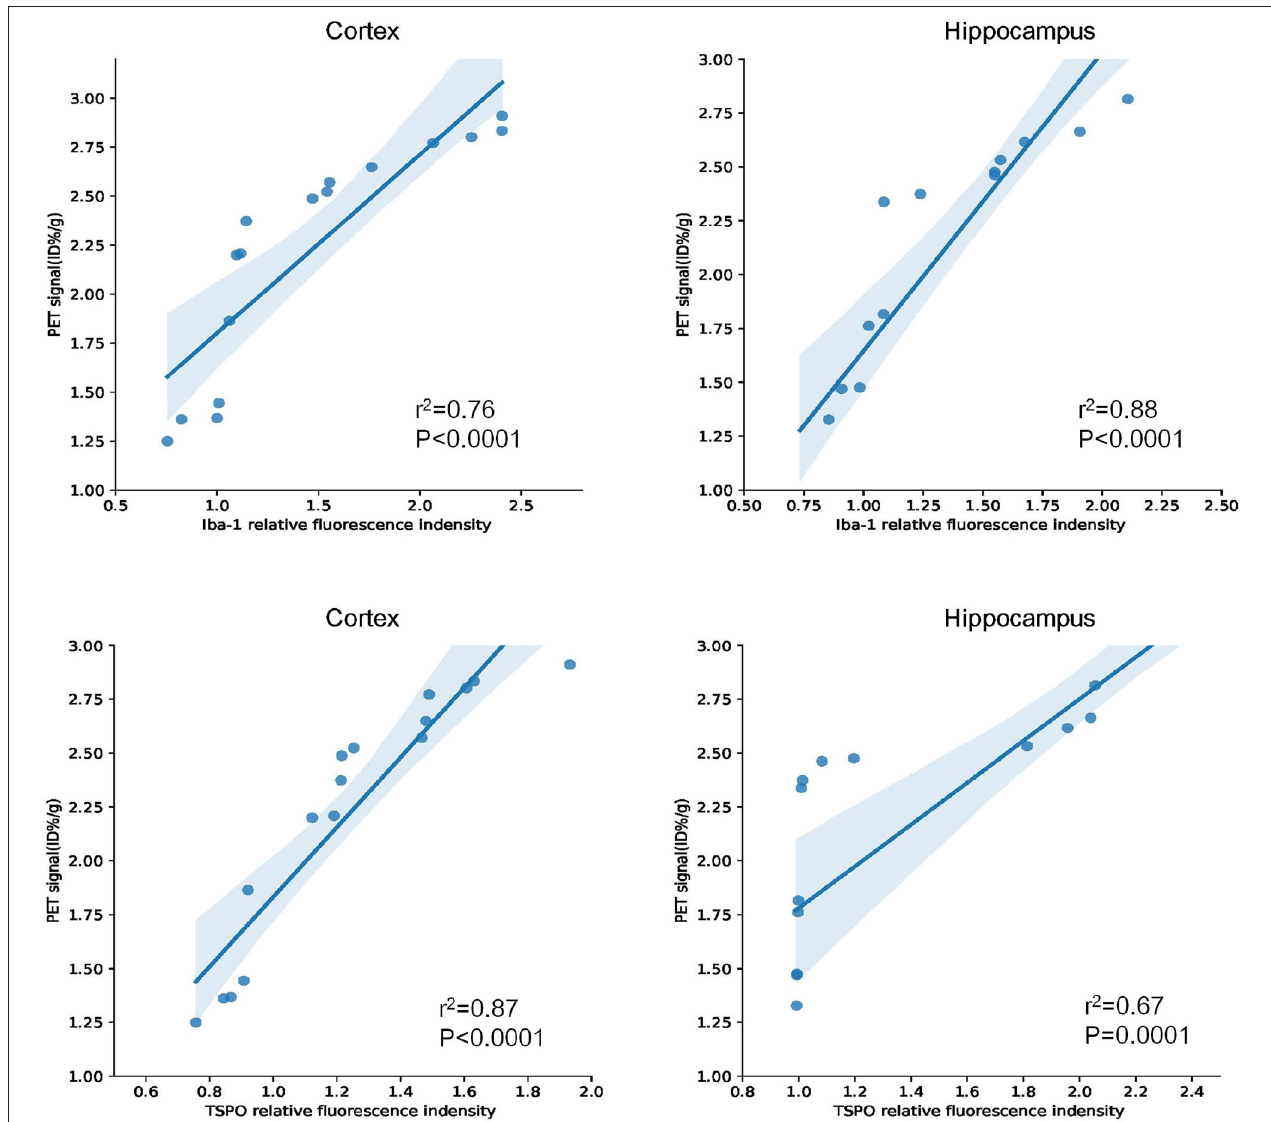
FIGURE 9 | Pearson correlation analysis between Iba-1/TSPO relative fluorescence intensity and PET signal in the cortex and hippocampus for 15–16-months-old APP/PS1 and Wt mice ( n = 8/group).